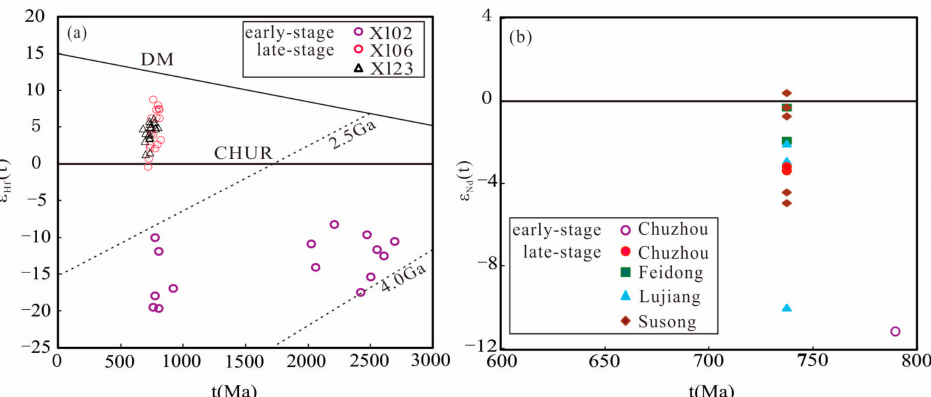
Figure 4. Plots of ( a ) zircon initial ε Hf value versus formation age; ( b ) whole-rock initial ε Nd value versus formation age for volcanic rocks of the Xileng Formation. DM: depleted mantle; CHUR: chondritic uniform